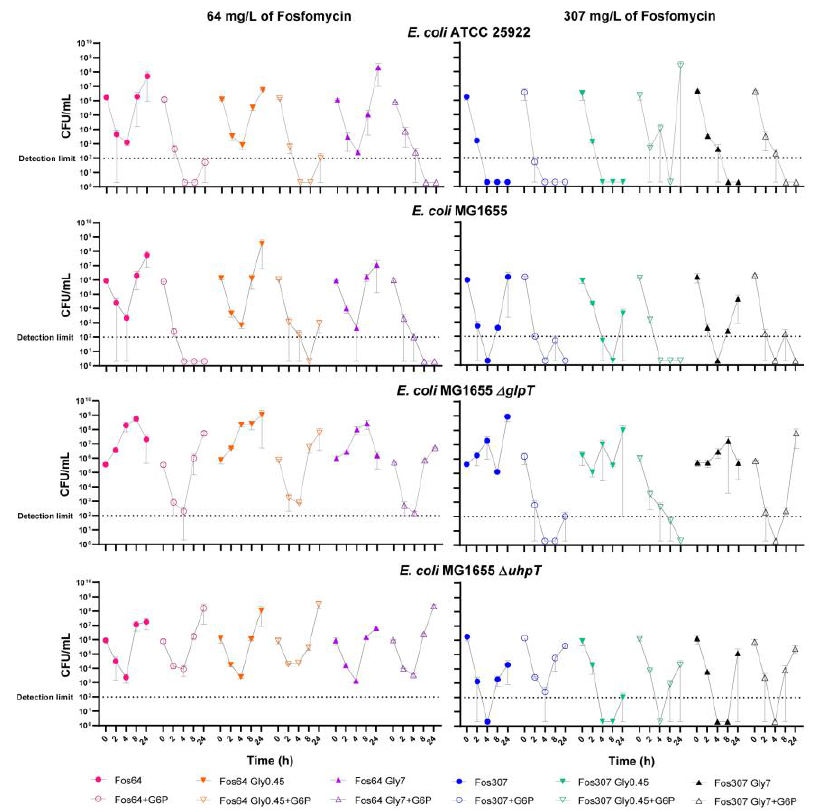
Figure 4. Time-kill assays of fosfomycin alone and in combination with glycerol (0.45 and 7 mg/L) and/or glucose-6-phosphate (G6P, 25 mg/L) against E. coli wild-type E. coli ATCC25922 and E. coli MG1655 wild-type and mutant derivative strains (∆ glpT and ∆ uhpT ), at 0, 2, 4, 8, and 24 h. Bacterial concentrations (CFU/mL) are represented as symbols for mean and range.